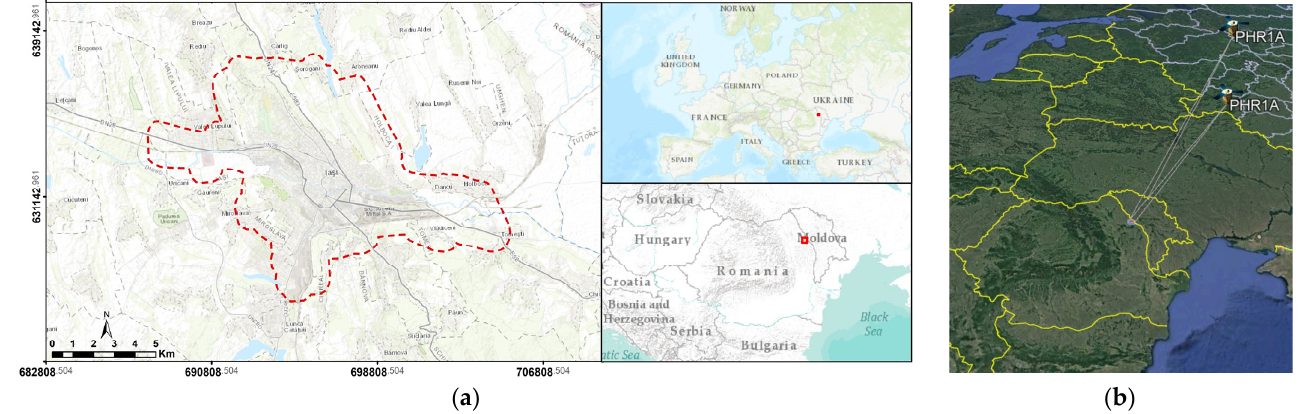
Figure 3. ( a ) Location of the study area; ( b ) acquisition geometry of stereo Pléiades satellite images. Table 1. Acquisition parameters of stereo Pl é iades